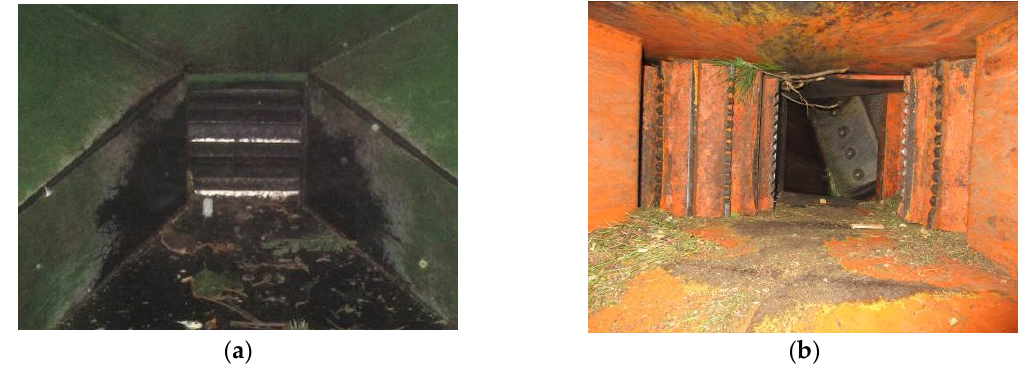
Figure 1. Detail of infeed components (rollers) ( a ) and knife on the disk shaft ( b ) of the surveyed in ‐ use wood chippers.